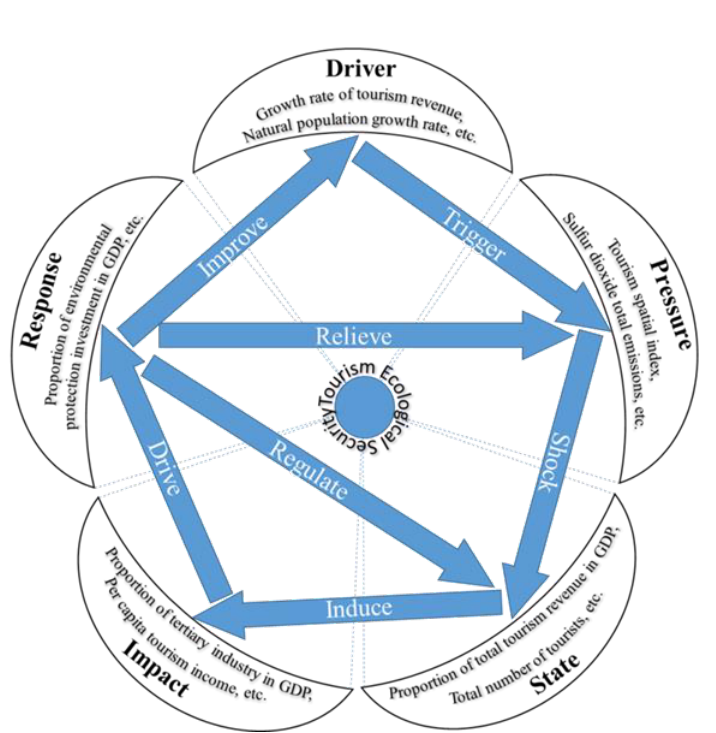
Figure 2. The DPSIR conceptual model for tourism eco-security evaluation.